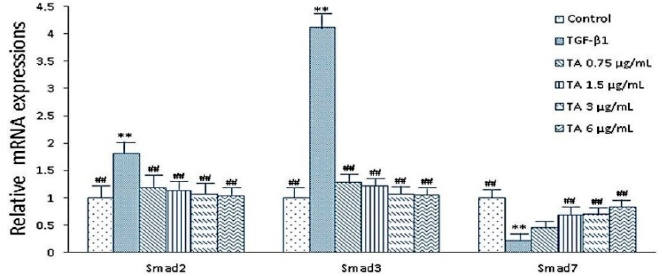
Figure 5. Effects of acteoside on the expressions of smad2, smad3 and smad7 in HSC (RT-PCR assay). Data were expressed as mean ± SD. ** p < 0.01 compared with control group, ## p < 0.01 compared with TGF- β 1 group.